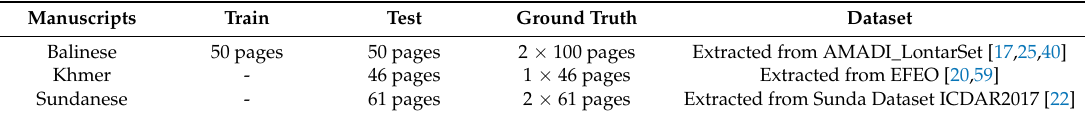
Table 1. Palm leaf manuscript datasets for binarization task.